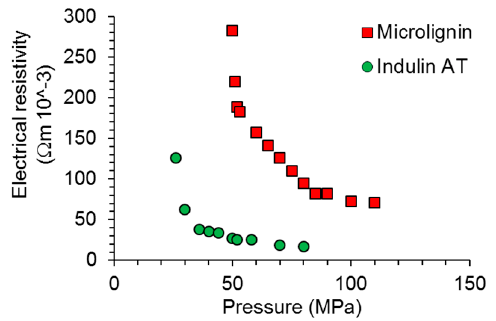
Figure 6. Pressure-dependent electrical resistivity along the out-of-plane direction of cellulose nanopapers filled with the two types of lignin-derived carbon particles.